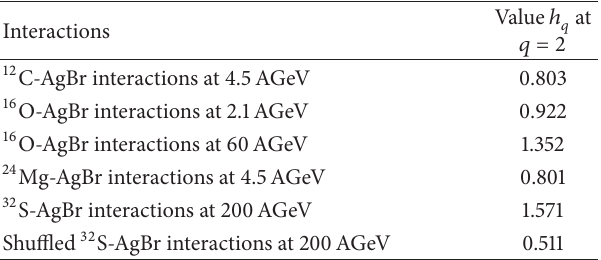
Table 1: Hurst exponent for the different